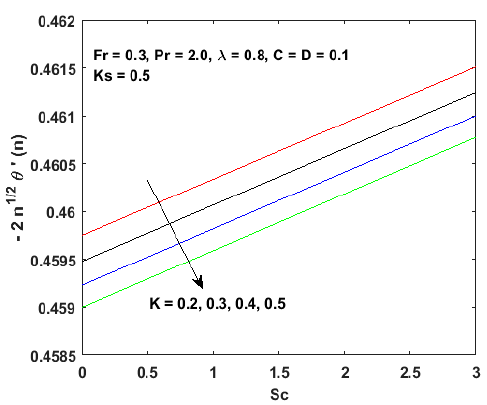
Figure 14. E ff ect of K and Sc on − 2 n 1/2 θ (cid:48) ( n ) . Figure 14. Effect of K and Sc on